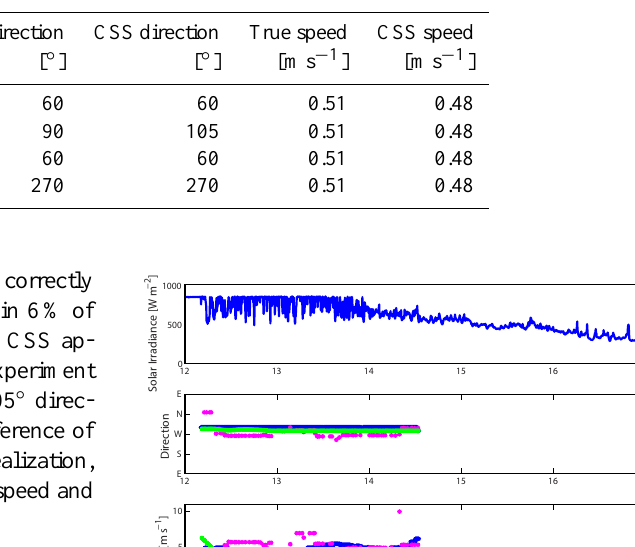
Table 1. CSS performance for the artificial cloud shadow experiment.